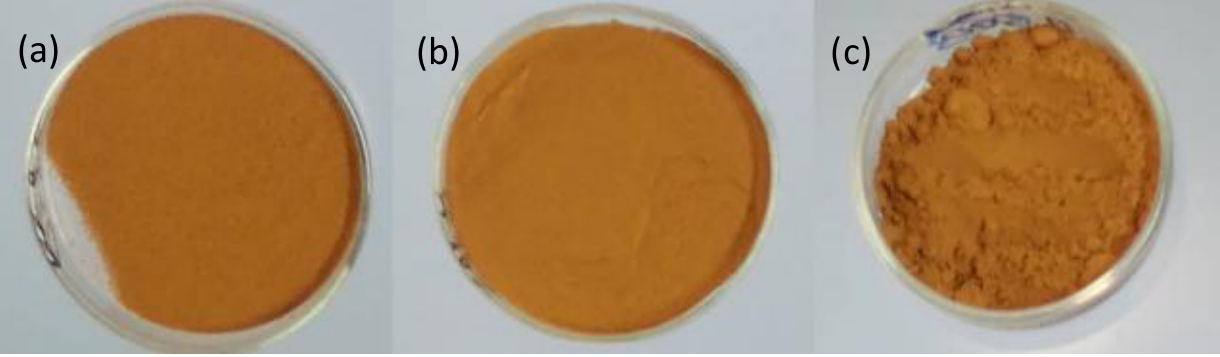
Figure 3. Almond bark powder with different sizes: (a) 0.500 mm granulometry, (b) 0.281 mm granulometry and ( c ) 0.063 mm granulometry.